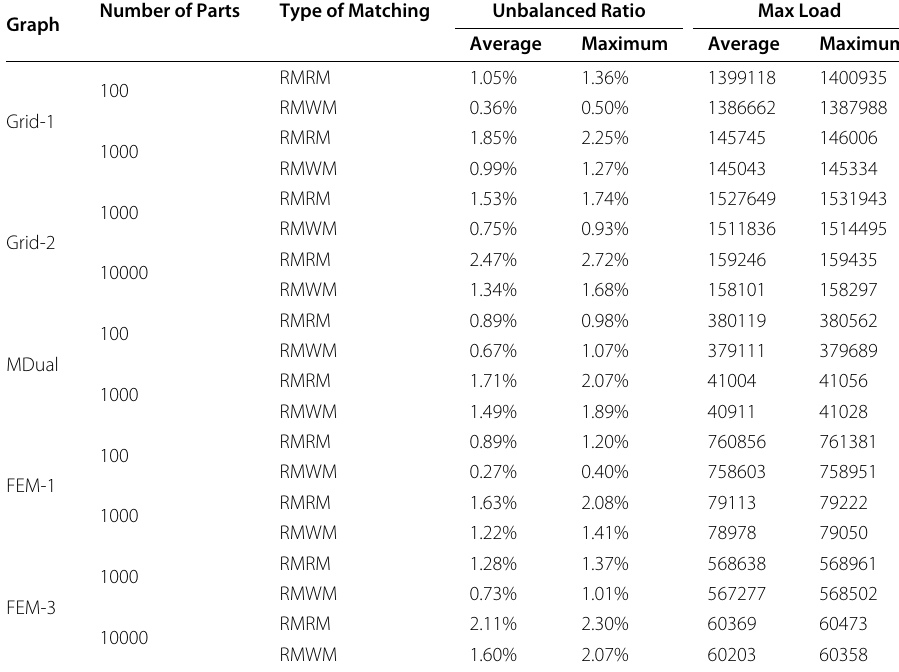
Table 2 The Experimental Result on Different Matchings Graph